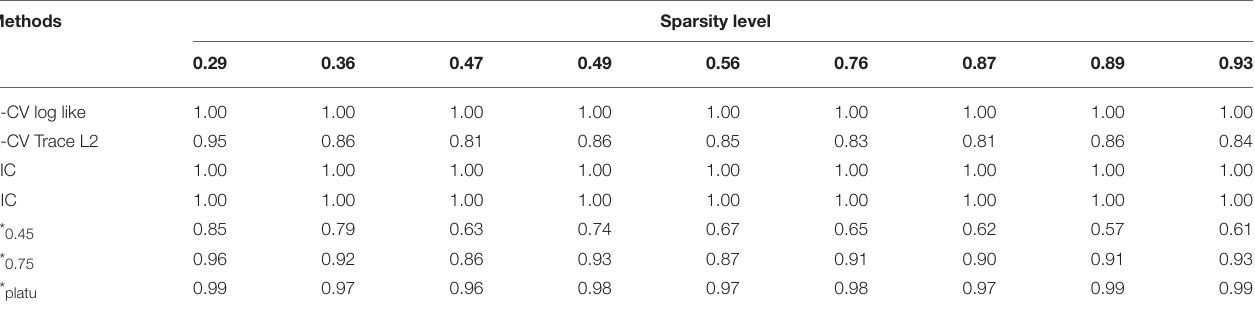
TABLE 3 | Comparison of Sensitivity for identifying connections based on different regularization selection methods across various sparsity levels with the simulated data.